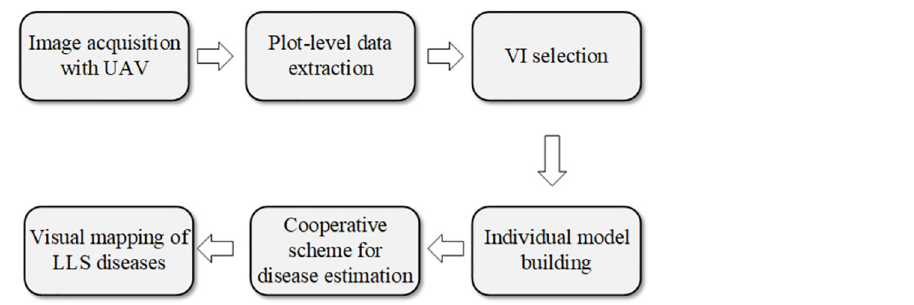
Fig 1. A block diagram showing the high-level workflow used in this study.